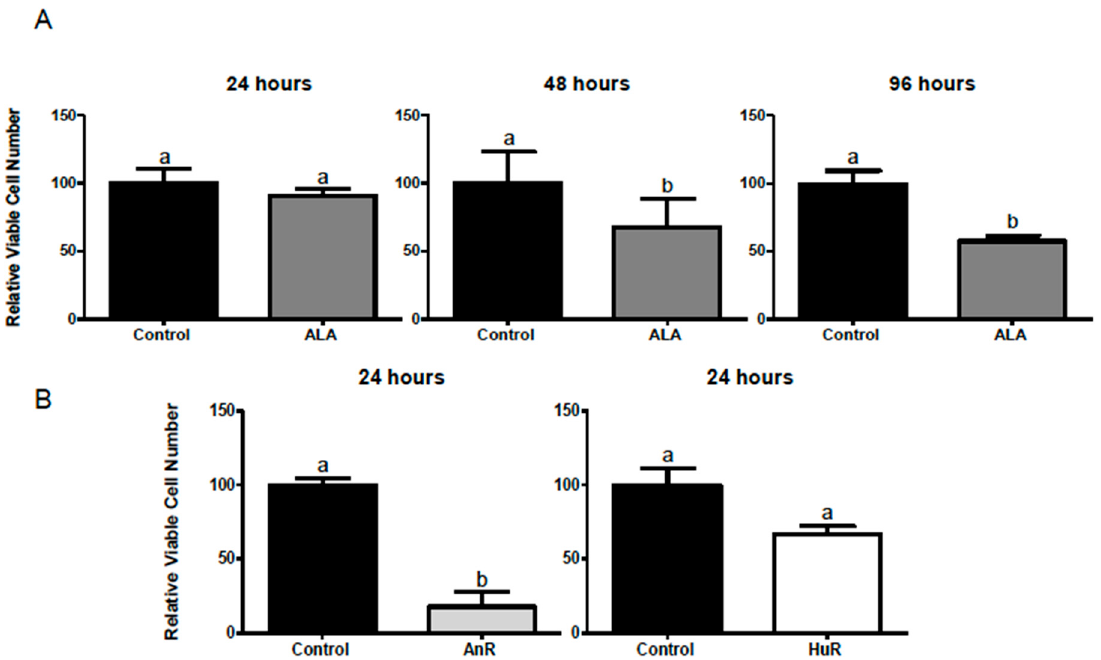
Figure 1. ( A ) Effect of 100 μ M ALA on cell viability after 24, 48 and 96 h treatment. No difference was seen after 24 h of treatment, but significantly fewer total live cells were found after 48 ( p < 0.005) and 96 h (<0.05); ( B ) Effect of ALA combined with EPA and DHA on cell viability after 24 h